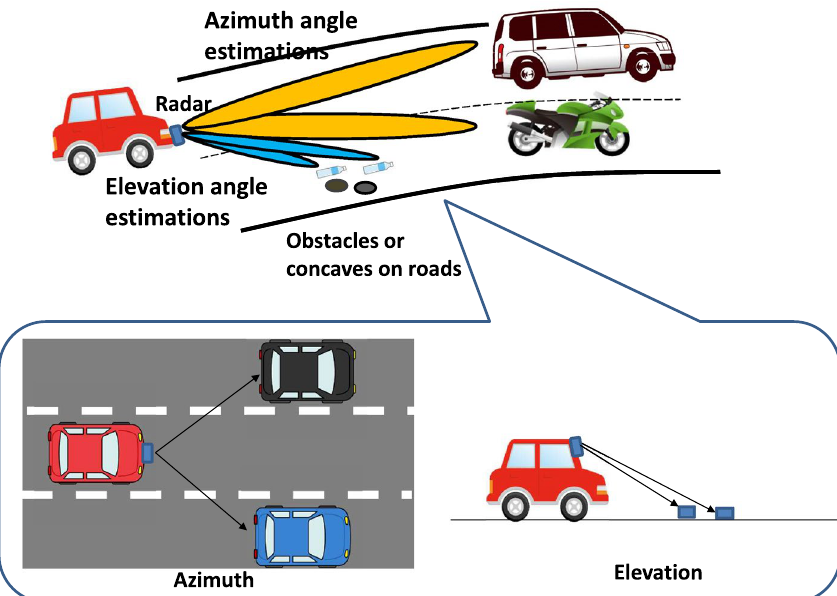
Figure 1. Need for higher resolution angle